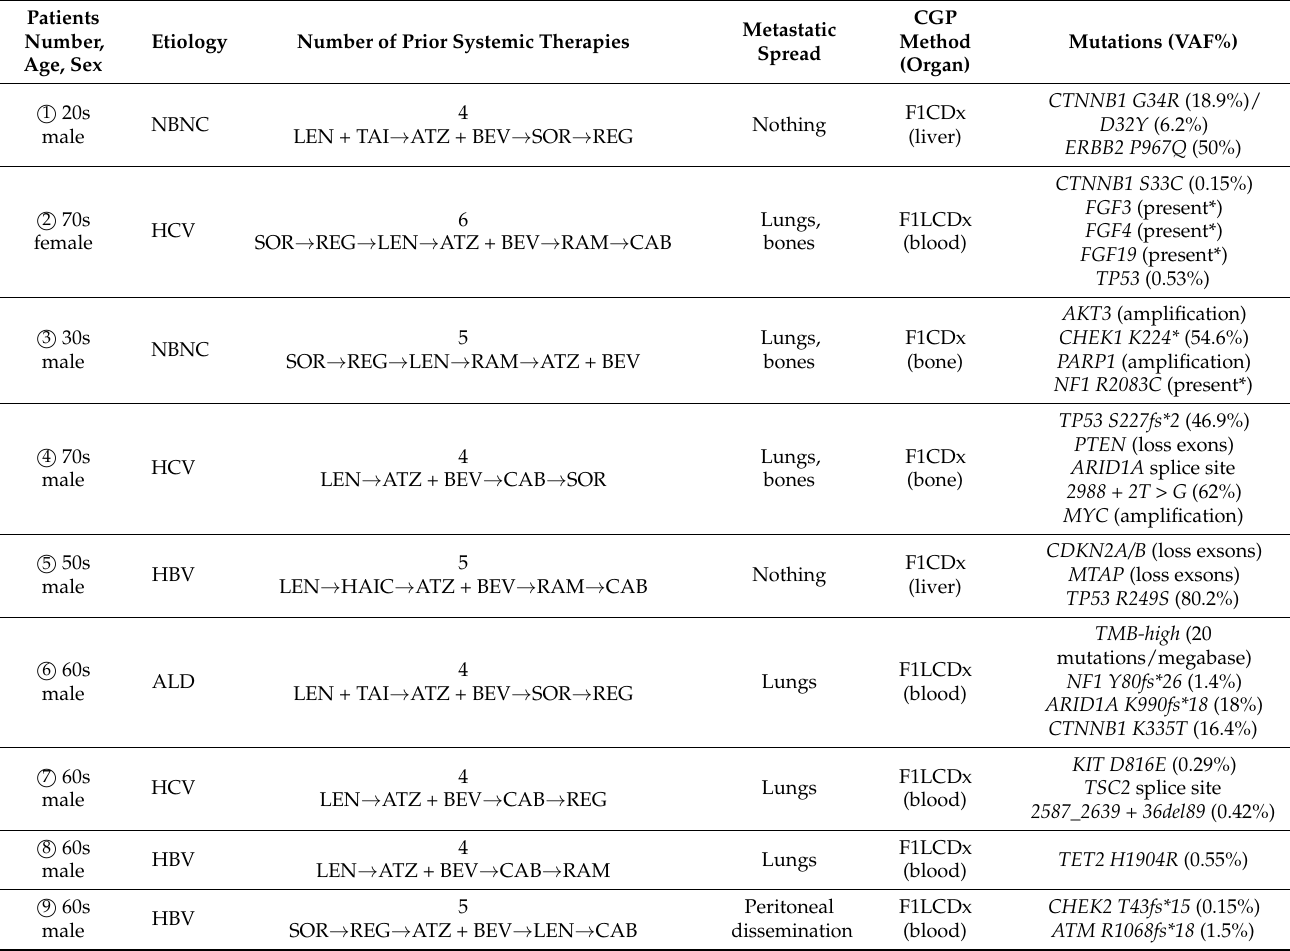
Table 2. The results of comprehensive genomic profiling